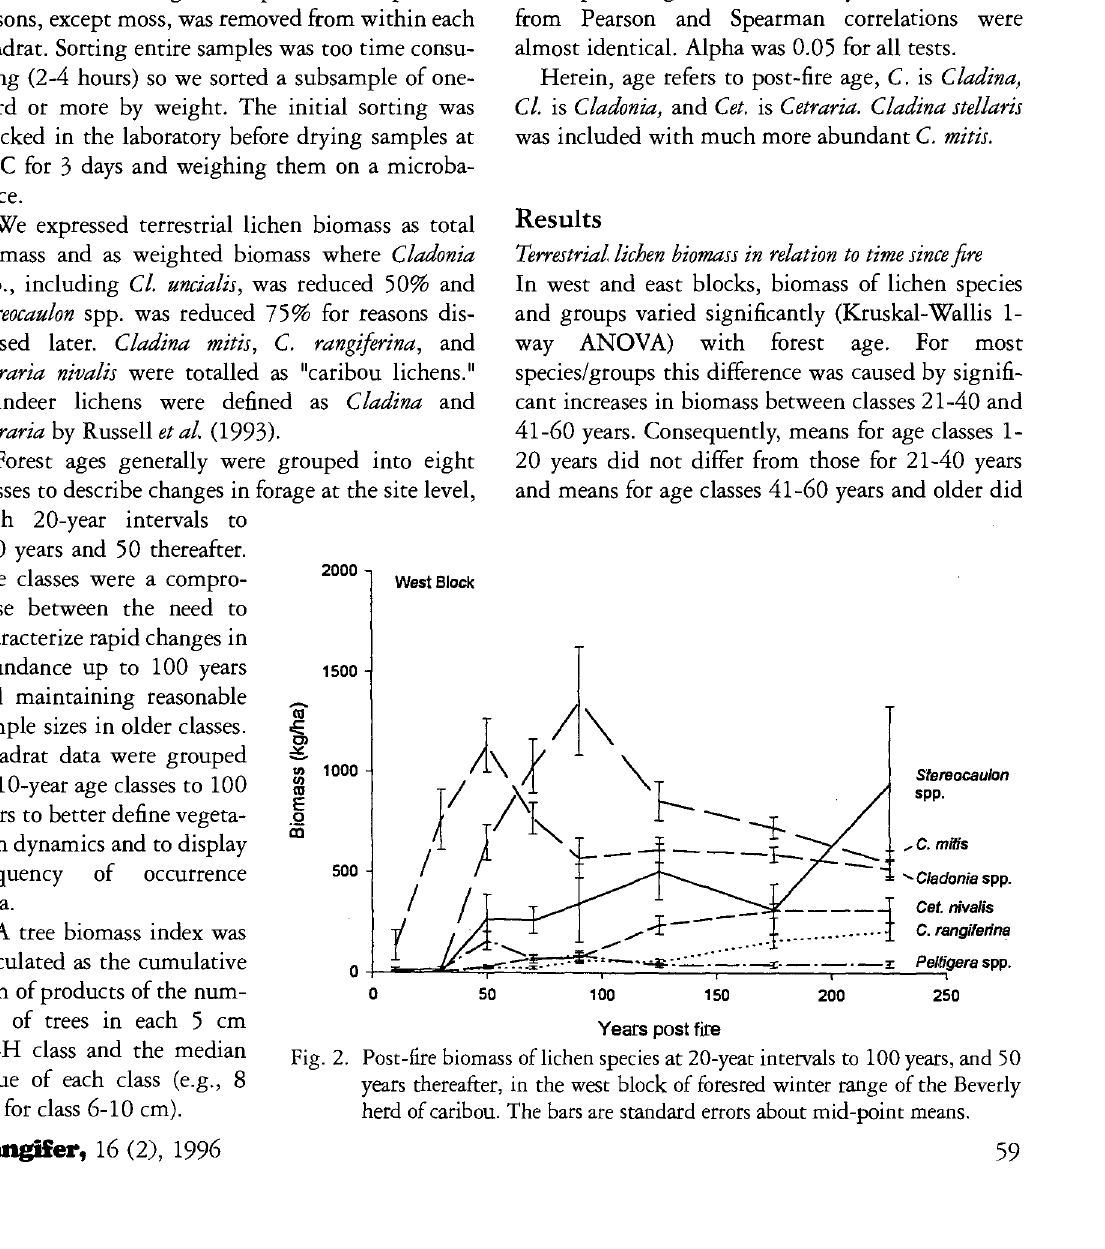
Post-fire biomass of lichen species at 20-yeat intervals to 100 years, and 50 years thereafter, in the west block of foresred winter range of the Beverly herd of caribou. The bars are standard errors about mid-point